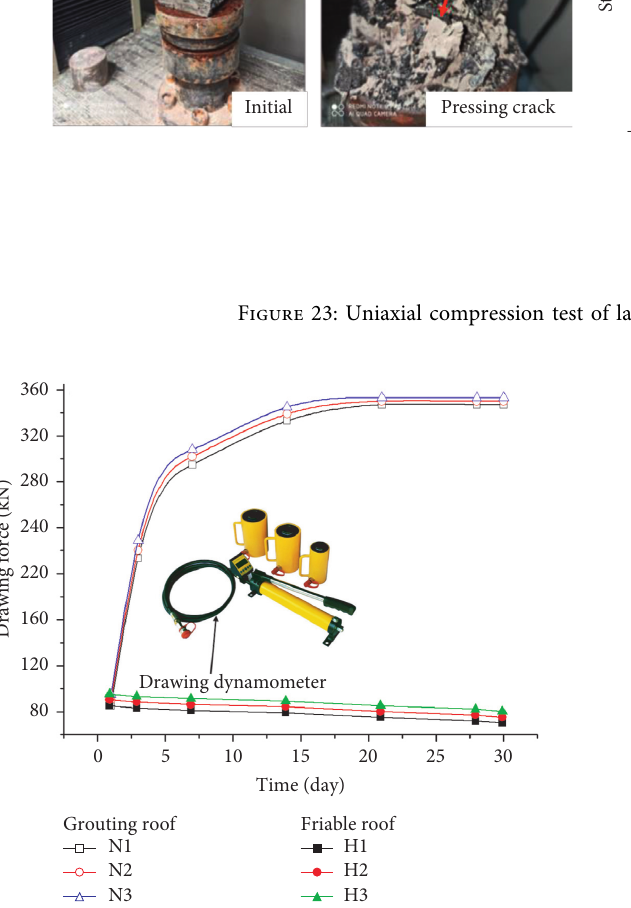
Figure 24: The drawing force of the grouting anchor